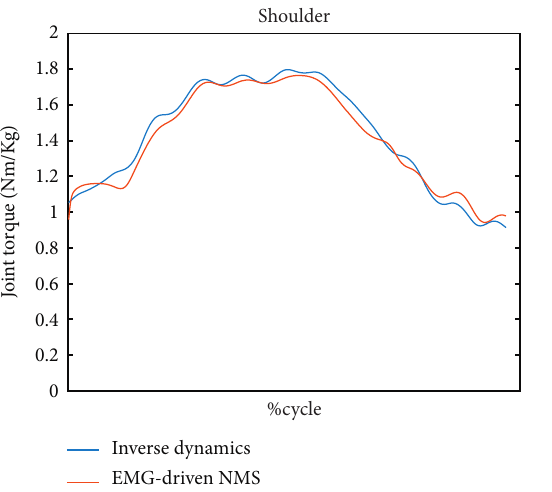
Figure 3: Shoulder joint torque (normalized by body mass) es- timated via inverse dynamics and EMG-driven NMS model.